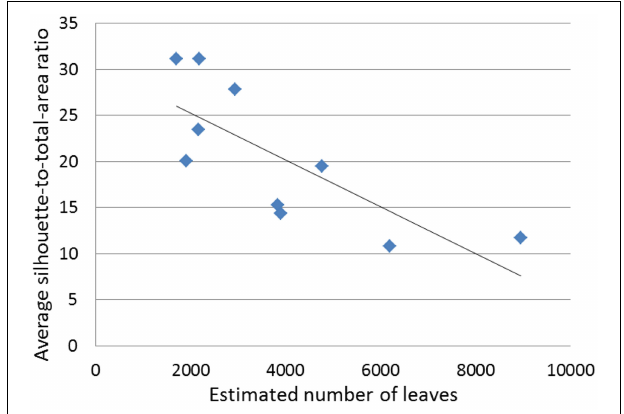
FIGURE 7 | Average silhouette-to-total-area ratio ( STAR ) against estimated number of leaves ( N ) for the 10miniature conifers with needlelike